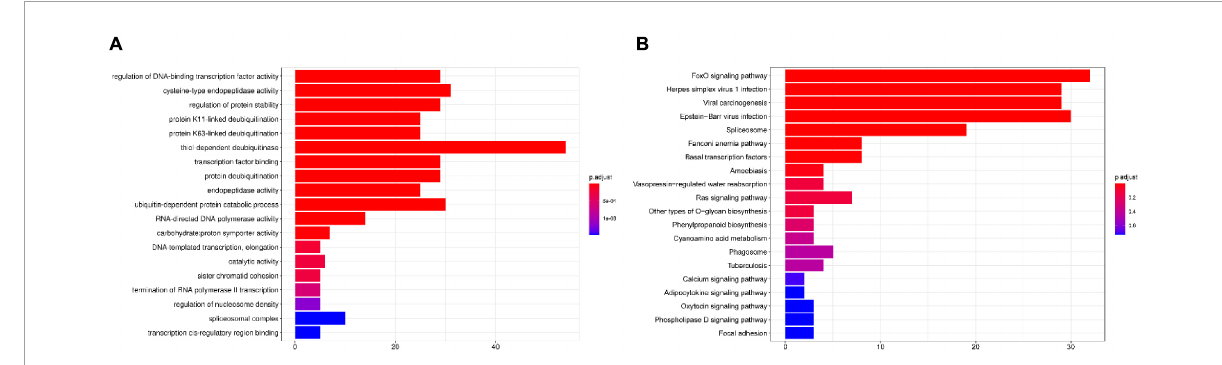
FIGURE10 Gene family enrichment analysis of I. hispidus compared with other 14 fungi. (A) GO enrichment results of the share gene family. (B) KEGG enrichment results of the shared gene